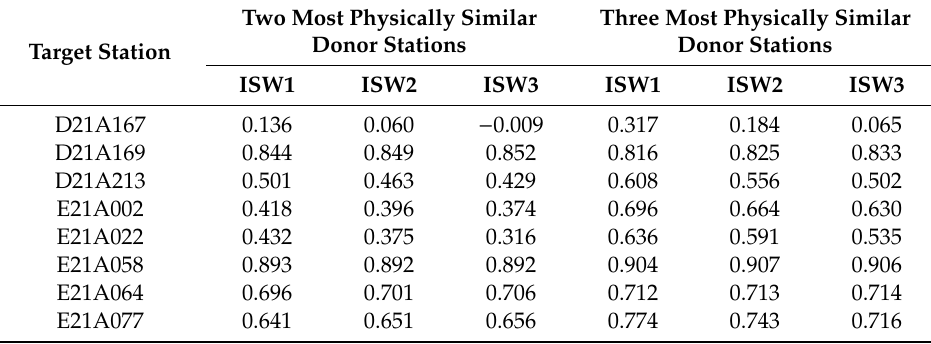
Table 8. NSE values for the inverse similarity weighted (ISW) with powers of 1, 2, and 3 in the Middle Euphrates